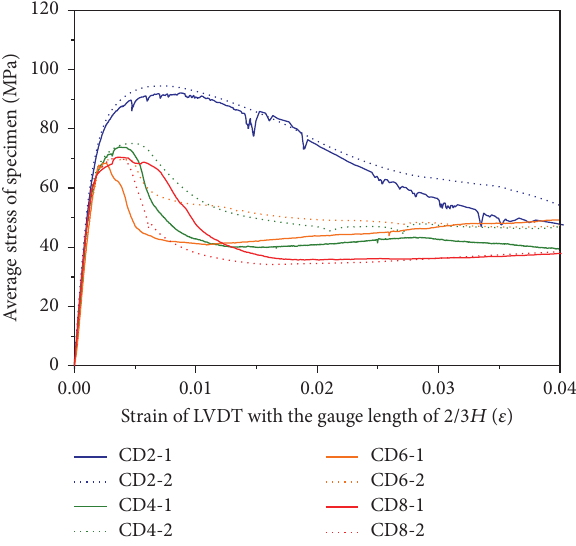
Figure 5: Average stress-strain curves of specimens. Table 4: Test results at moment of peak bearing capacity for each specimen.